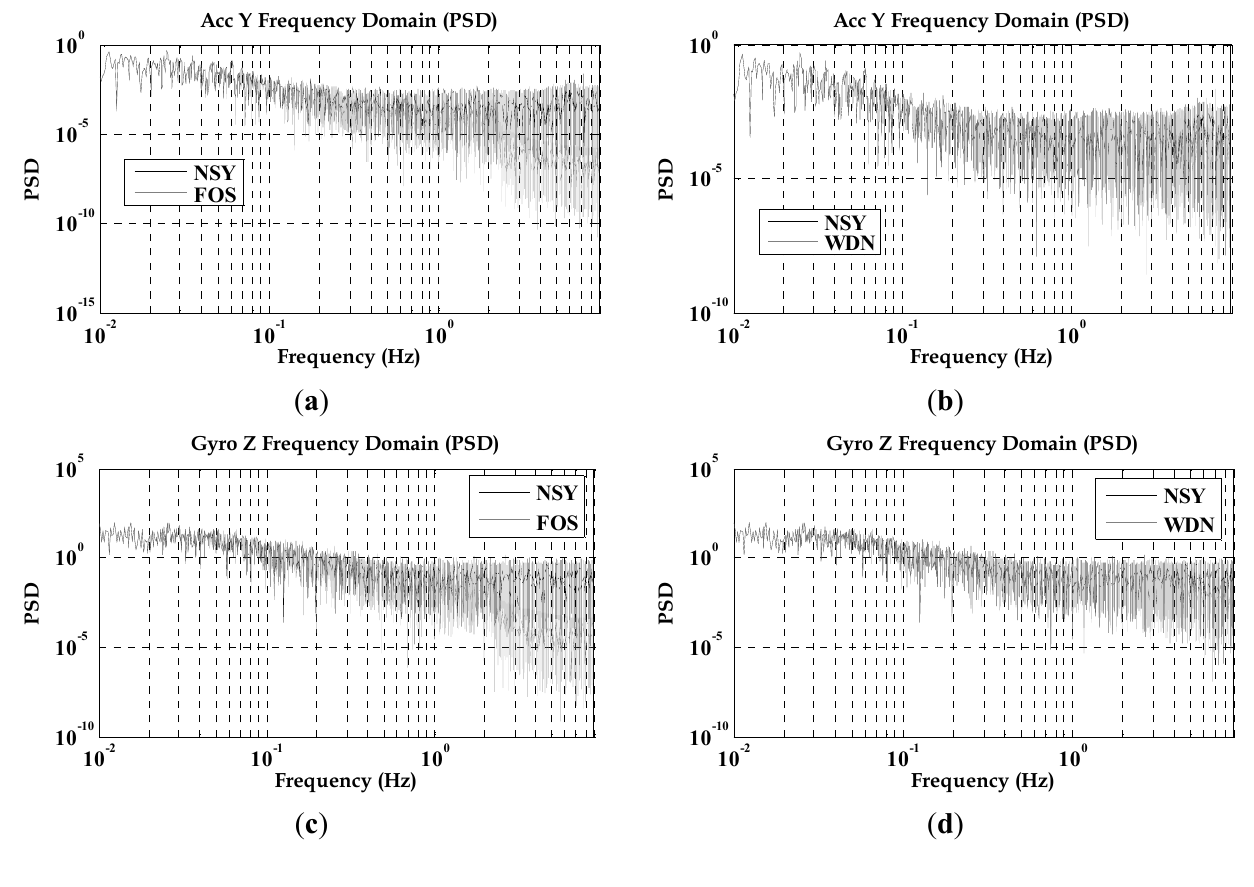
Figure 13. PSD plots for MEMS inertial sensors before and after applying both FOS and